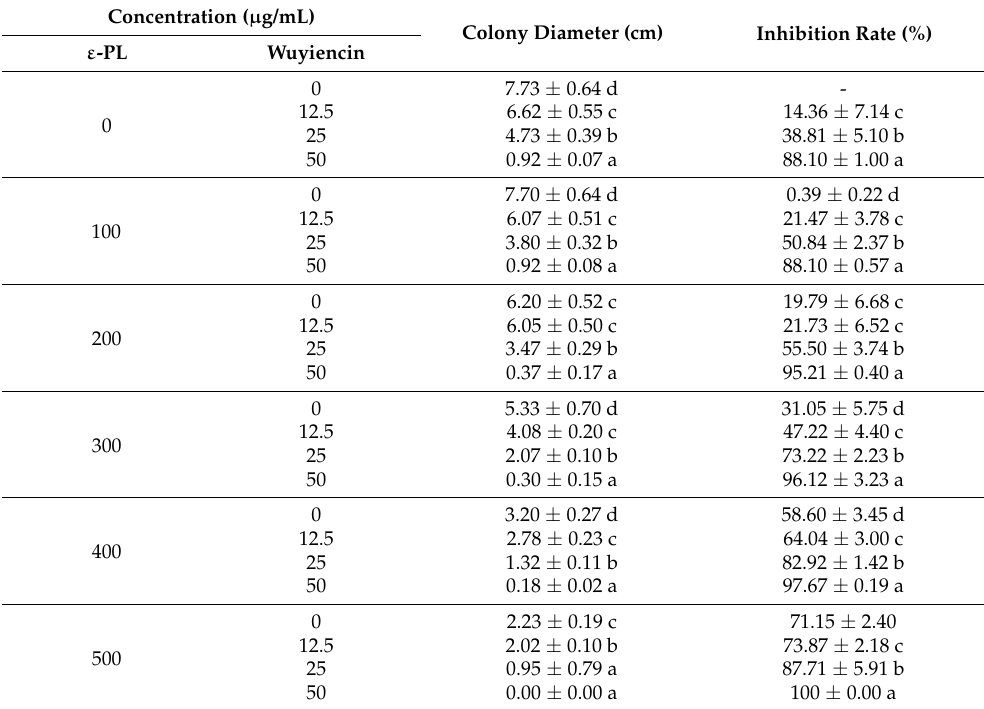
Table 2. Inhibitory effect of wuyiencin and ε -PL at different concentrations on the mycelial growth of Botrytis cinerea